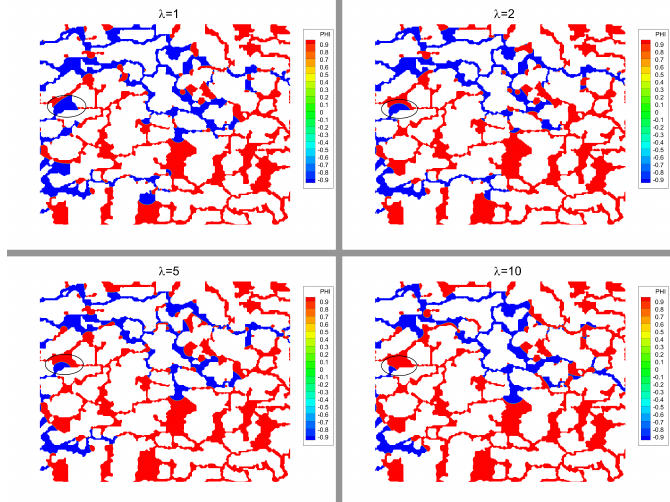
Figure 4. Fluid distributions at breakthrough for a wetting fluid invading a porous medium initially saturated with a non-wetting fluid. The wetting fluid (indicated in blue) is injected from the left side, and the viscosity ratio λ equals 1, 2, 5, and 10,